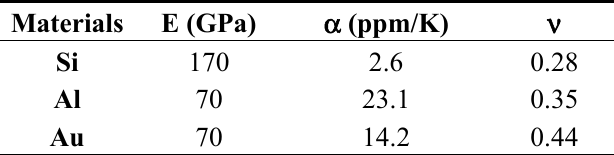
Table 1. Material parameters for